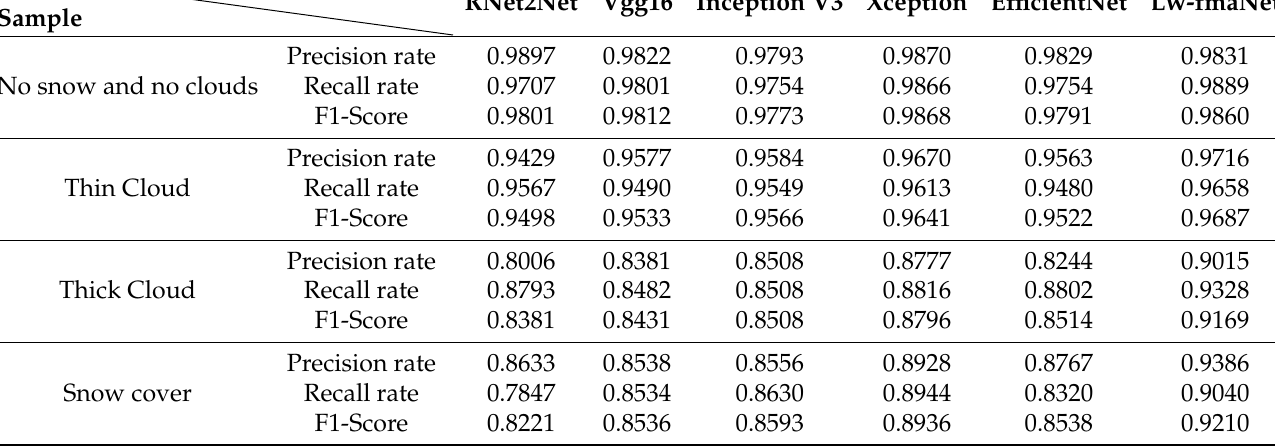
Table 5. Classification and evaluation index analysis of cloud and snow recognition network (1).